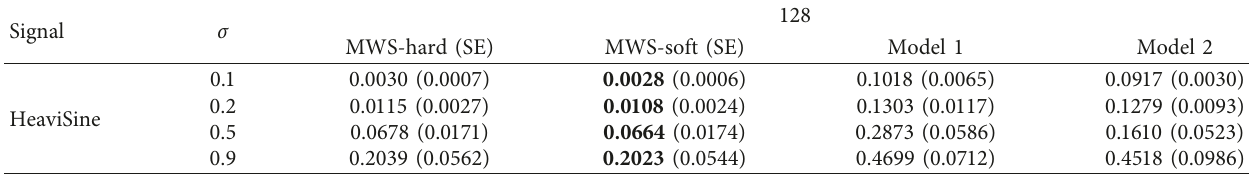
Table 2: Comparison of nondecimated complex wavelet shrinkage methods for 128 wavelet coefficients: CMWS-hard and CMWS-soft. Results are AMSE and standard errors replicated 1000 for estimation of standard test functions. The bold font indicates the smallest AMSE result.